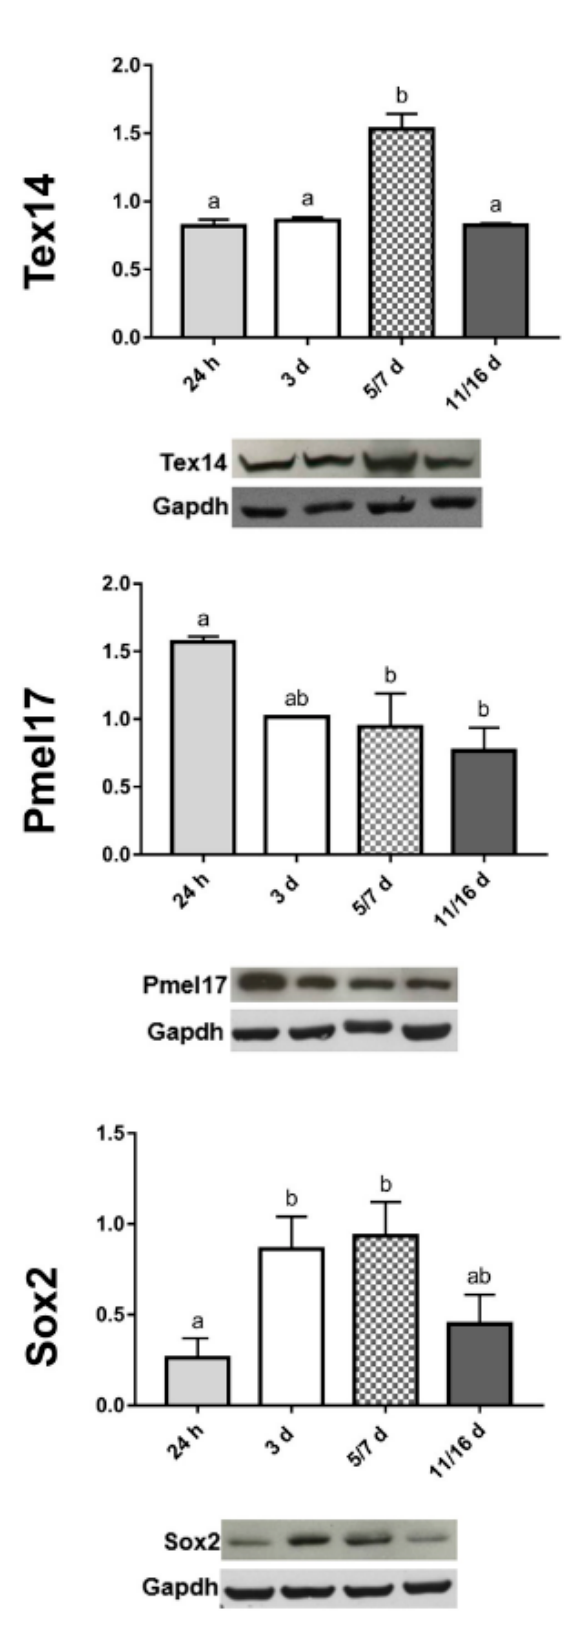
Figure 4. Semiquantitative / quantitative analysis on spheroids. The graphs illustrate the expression levels of TEX14 ‐ intercellular bridge forming factor, the Pmel17 ( amyloidogenic protein), and the Sox2 ‐ stemness marker, respectively, at different stages of spheroid formation. The data result from a